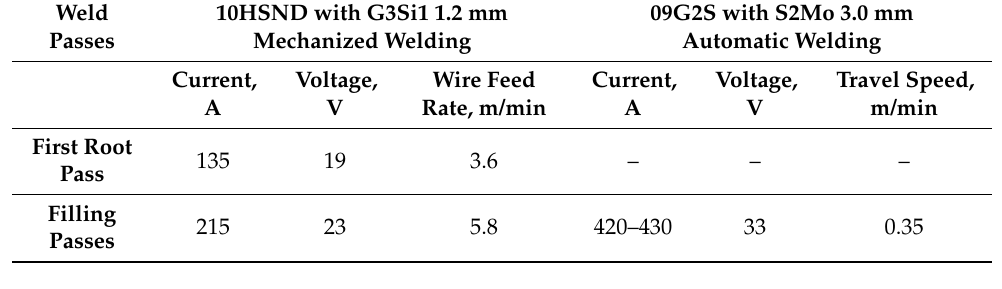
Table 3. Welding parameters for 10HSND, 09G2S.